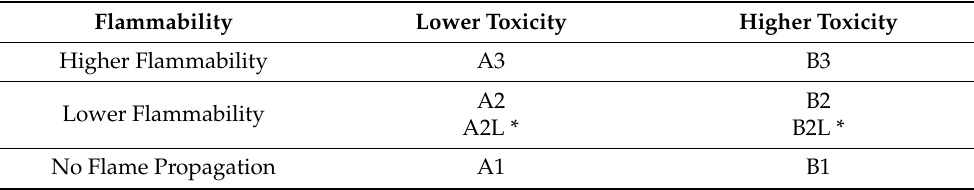
Table 3. Safety classes for refrigerants according to ASHRAE Standard 34 [36] and ISO 817:2014